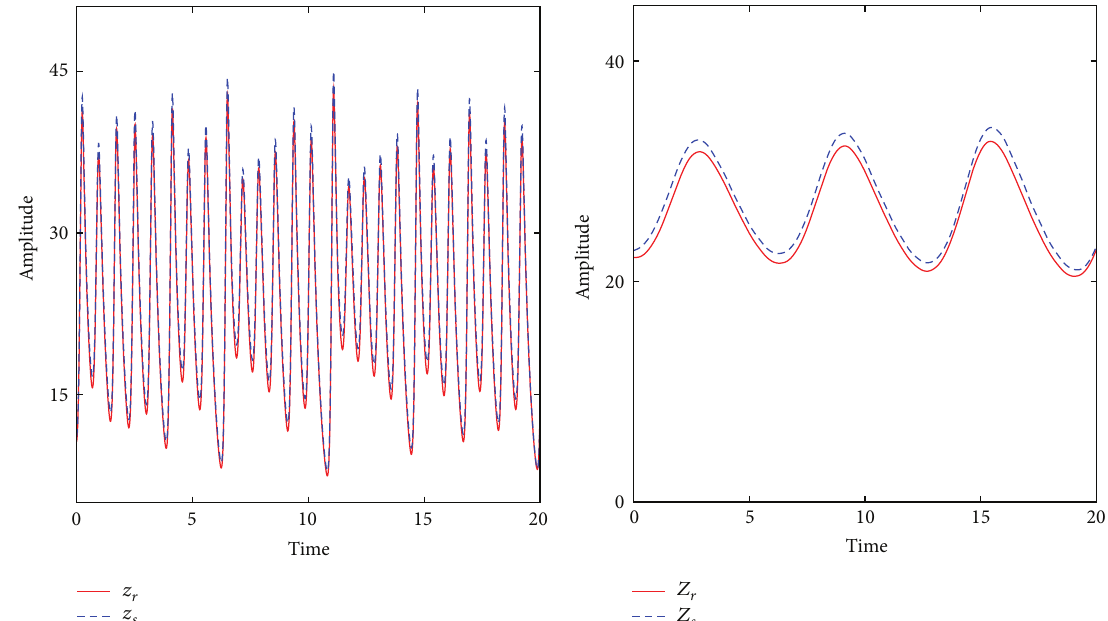
Figure 9: Original trajectory (in red) and pseudoorbit (in blue) for the fast 𝑧 and slow 𝑍 variables for 𝑐 0 = 0.01 .